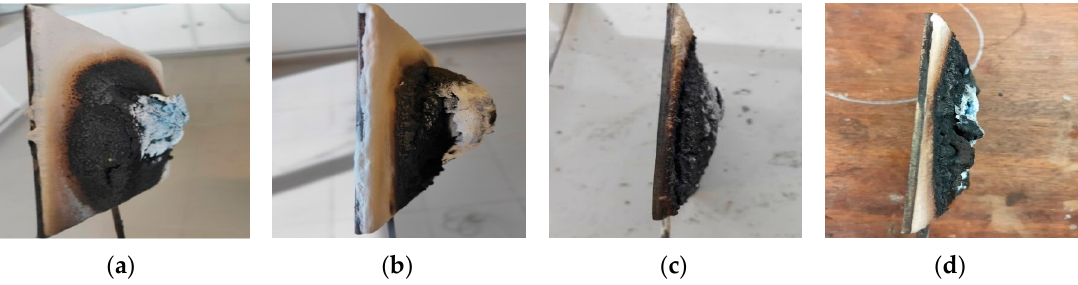
Figure 3. After one-hour fire resistance test: ( a ) BAIC 1-0, ( b ) BAIC 3-5, ( c ) BAIC 5-0, ( d ) BAIC 10-0. This result reveals that 3.5 wt.% of BioAsh added into BAIC 3-5 induced an optimum physical and chemical reaction with 6.5 wt.% TiO 2 , and APP-PER-MER / VAC in the formula, resulting